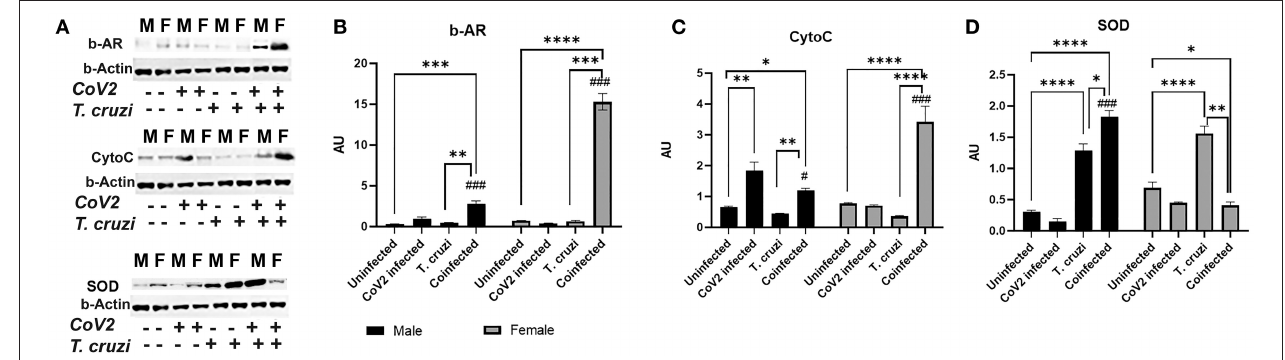
FIGURE 8 | Immunoblot analysis of β -Adrenergic Receptor and markers of mitochondrial β -oxidation in the hearts of CoV2 infected, T. cruzi infected, and coinfected huACE2 mice. Western blot images (A) of β -Adrenergic Receptor ( β -AR), cytochrome C (Cyto C), and superoxide dismutase (SOD). β -Actin was used as loading control. Fold changes in the protein levels of β -AR (B) , Cyto C (C) and SOD (D) were normalized to β -Actin expression and are shown as bar graphs (A dot plot displaying individual data points is presented in Supplementary Figure 4 ). The error bars represent standard error of the mean. * p < 0.05, ** p < 0.01, *** p < 0.001 and **** p < 0.0001 compared to uninfected sex matched mice ( n = 4/sex/group) ( # p ≤ 0.05 and ### p ≤ 0.001 for comparisons between CoV2 infected and coinfected mice) (M, male; F,